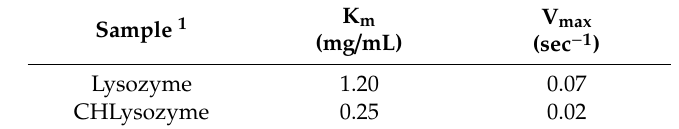
Table 2. K m and V max of lysozyme and CHLysozyme calculated from Lineweaver-Burk plot.